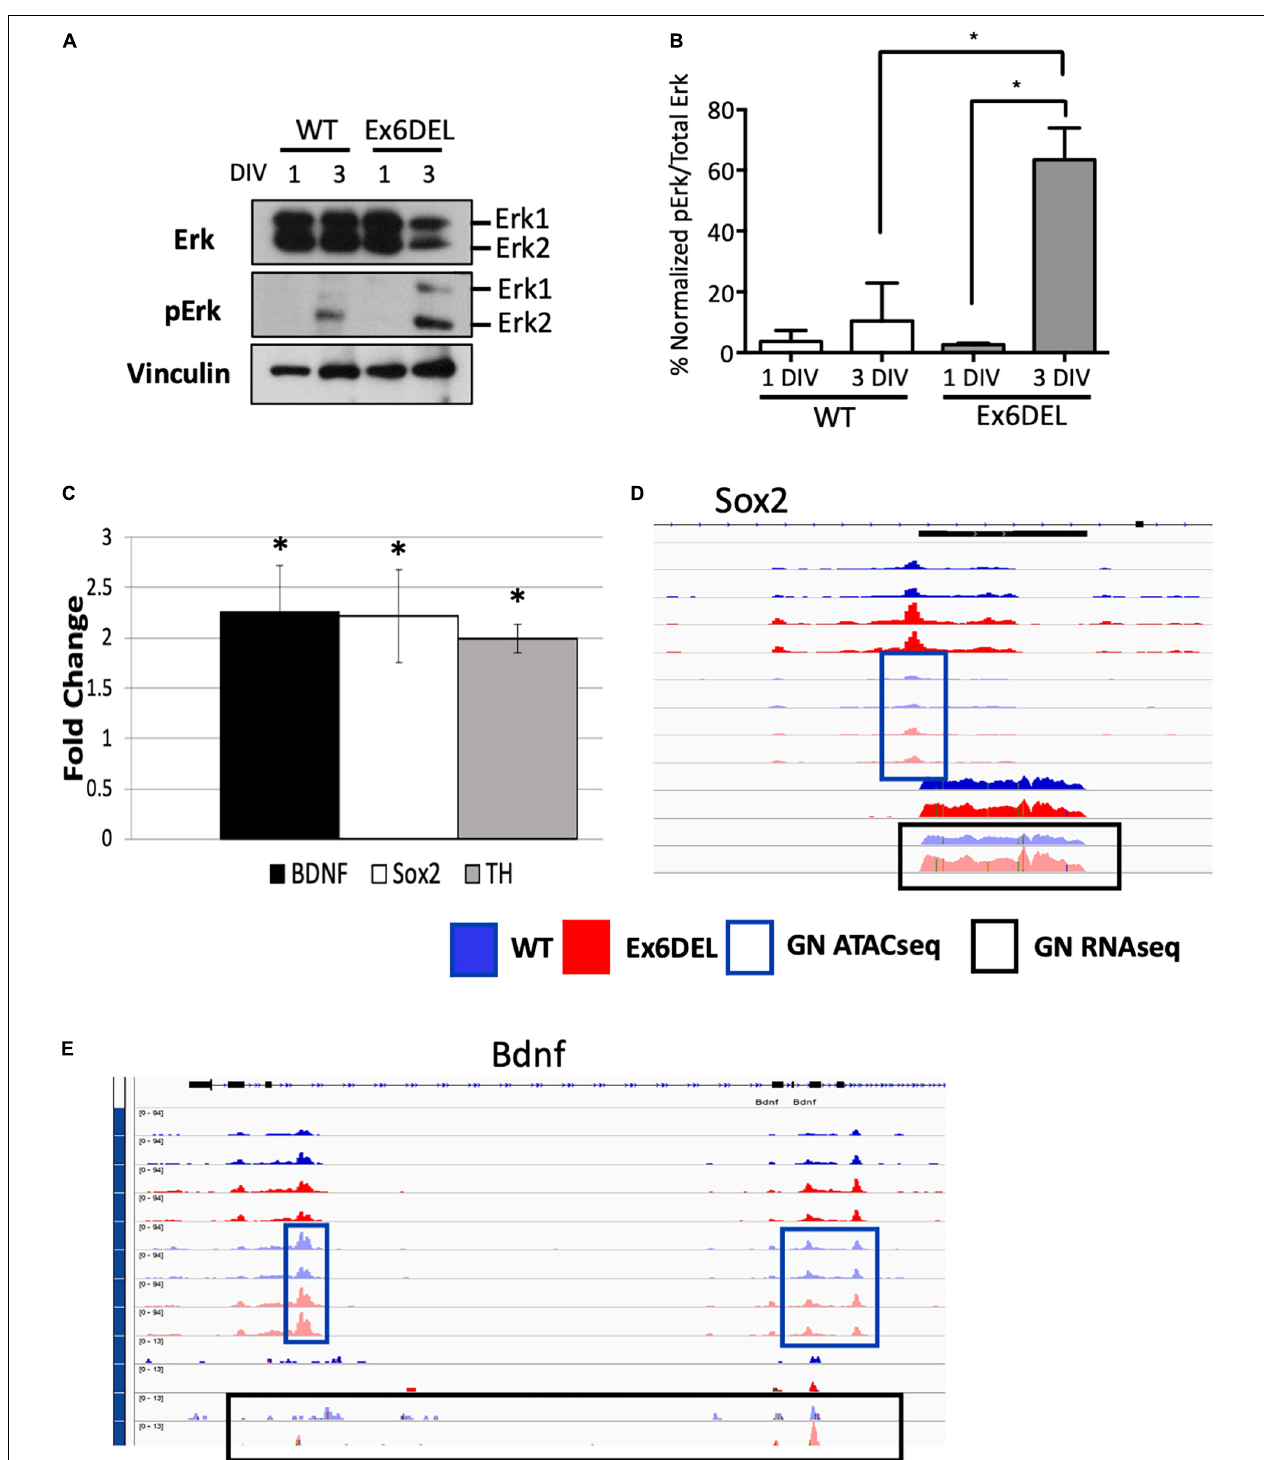
FIGURE 7 | Granule neuron precursor differentiation is associated with ERK signaling activation. (A) Immunoblots from WT and Ex6DEL GNP cultures (1 and 3 DIV) for Erk and phospho-Erk (pErk). Vinculin serves as a protein loading control. (B) Quantification of the immunoblots in A showing the normalized change in Erk activation (pErk1 + pErk2 level) to total Erk protein level. ∗ p < 0.05. (C) RT-qPCR validation of the expression of downstream target genes of ERK/Fos/Jun signaling. ∗ p < 0.05. (D) Genome browser views of the Sox2 (D) and Bdnf (E) genes. The blue boxes highlight the ATACseq peaks and the black boxes mark the RNAseq reads at 3 DIV. All unboxed tracks correspond to the I DIV